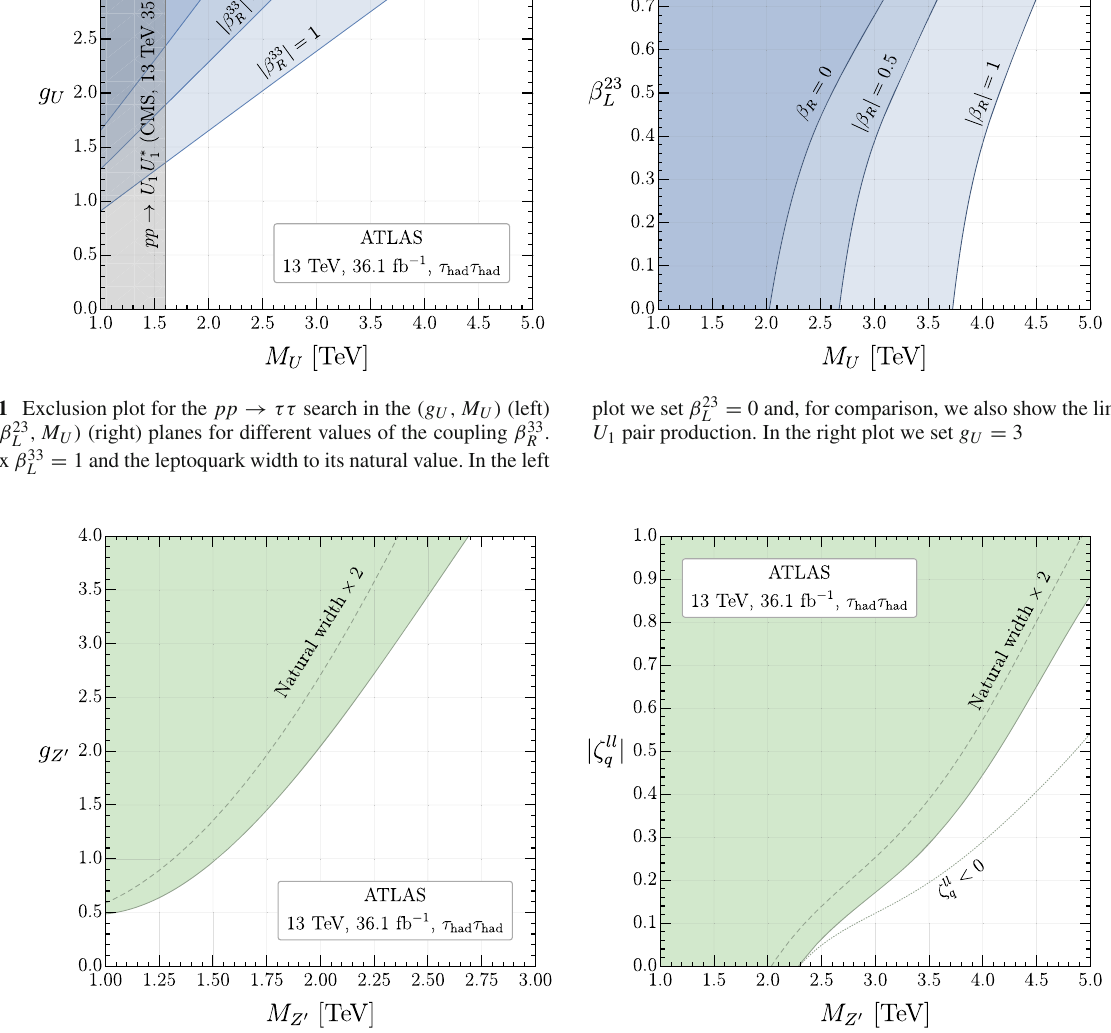
Fig. 2 Exclusion plot for the pp → ττ search in the ( g Z (cid:2) , M Z (cid:2) ) plane (left) and (ζ ll q , M Z (cid:2) ) plane (right), and for the natural width × 2 while maintaining the natural partial width to tau pairs (dashed curves). In the left plot we set ζ ll q = 0. In the right plot we set g Z (cid:2) =